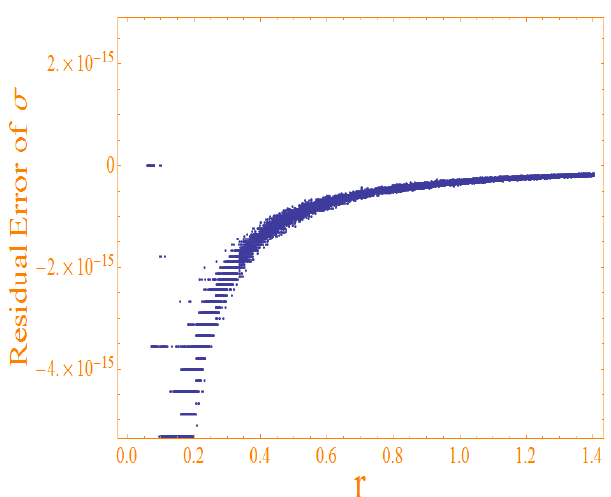
σ Coatings 2020 , 10 , 213